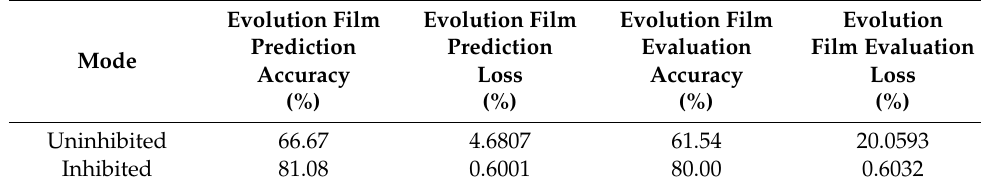
Table 3. The calculated accuracy of the passive film using ANN.